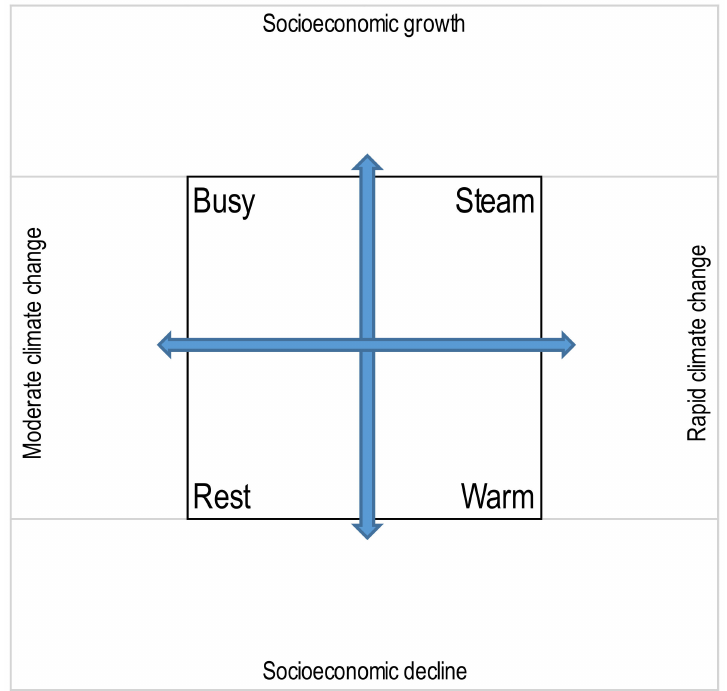
Figure 3. Graphical representation of delta scenarios